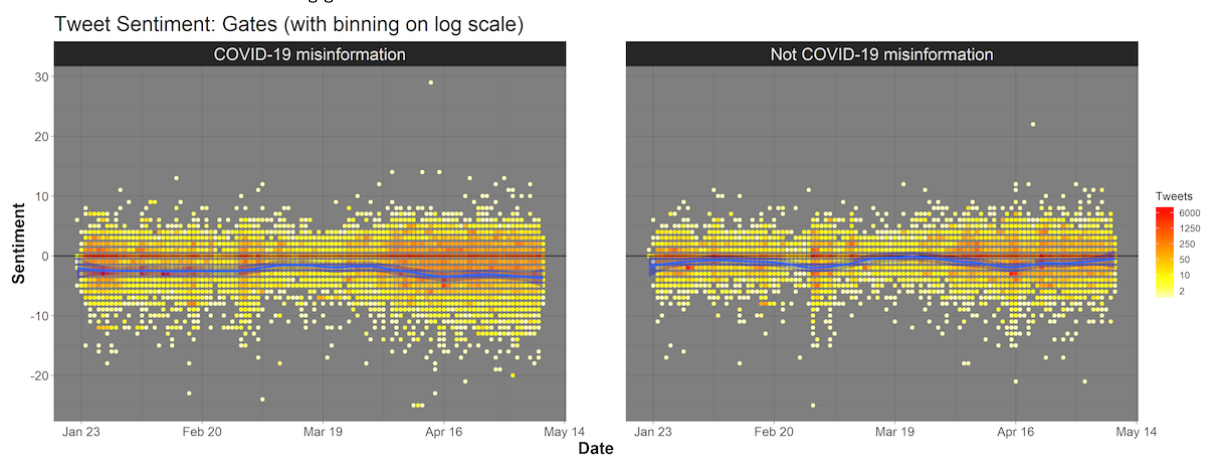
Figure 4. Sentiment comparison for data from tweets about COVID-19 conspiracy theories related to Bill Gates and the Bill & Melinda Gates Foundation by label. Tweets are plotted over time and stratified by misinformation status. Sentiment varies from highly negative to highly positive. Loess smoothing was used to draw the blue line indicating general trend over